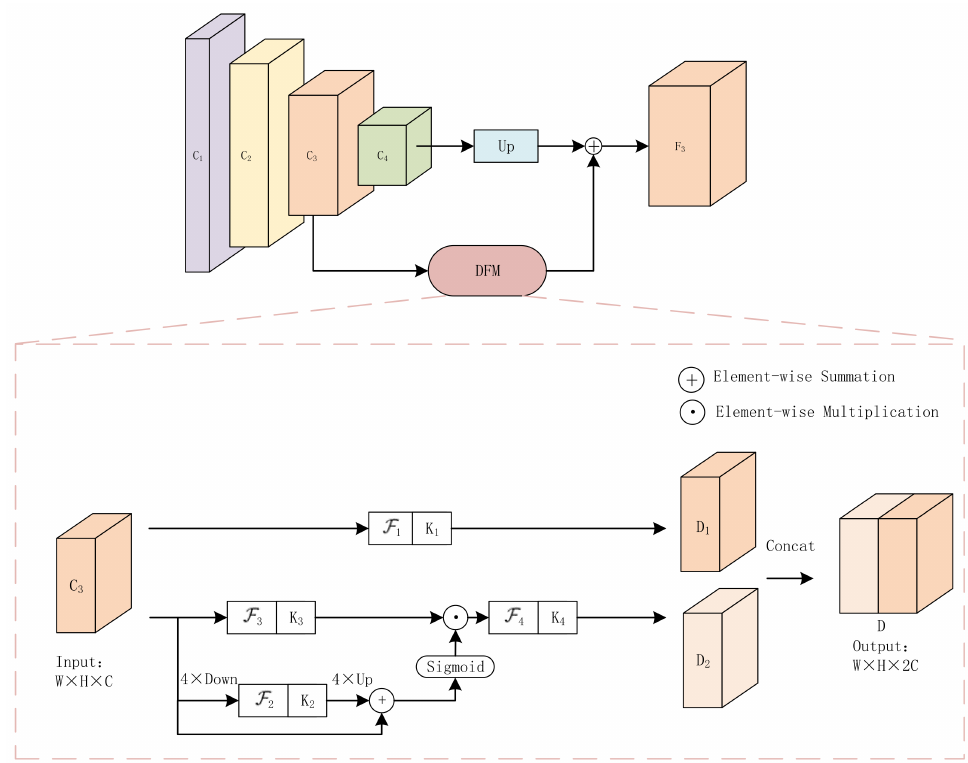
Figure 5. DFF-Net: firstly, C 3 is expanded the number of channels in the feature map by DFM, and then the deep feature fusion is carried out with C 4